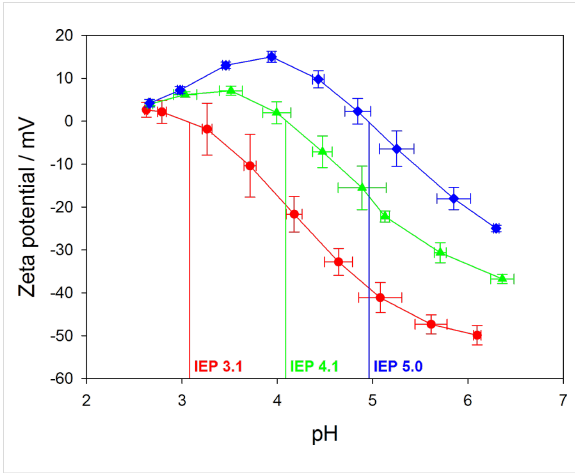
Figure 2: Titration of PLGA–PEI–PAA nanoparticles with HCl (25 mM) for different pH values during assembly of PAA. PAA assembly at pH 7 (blue), PAA assembly at pH 5 (green), PAA assembly at pH 3 (red). Experiments were performed in triplicate, average values ± standard deviations are shown.